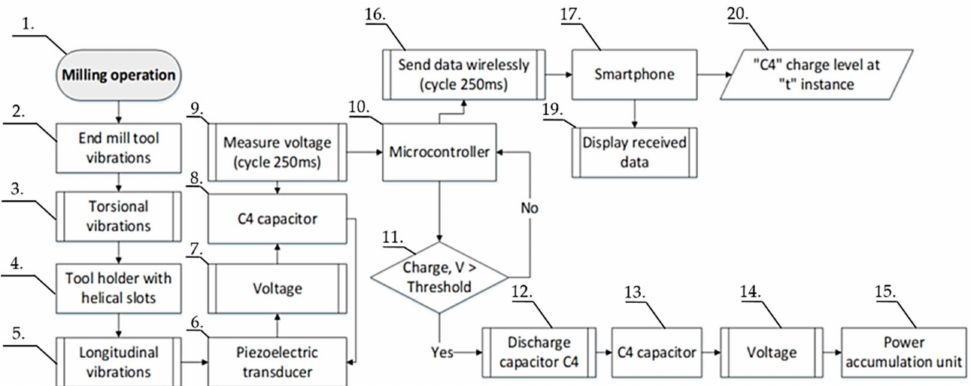
Figure 9. Working process flow of the wireless energy harvesting sensor node used to detect end mill tool condition wear